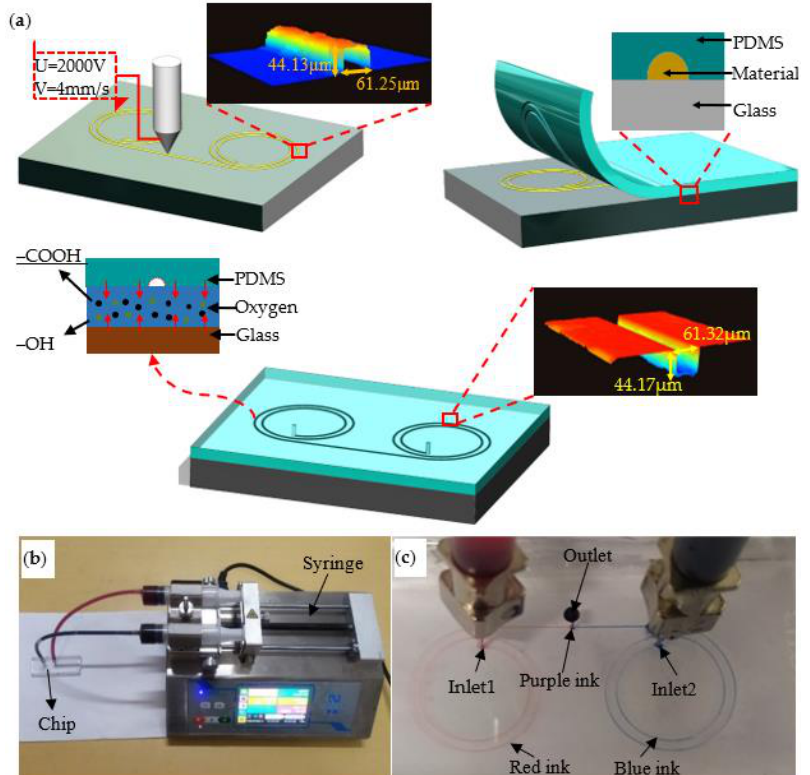
Figure 12. Fabrication of microfluidics chip: ( a ) schematic of microfluidic chip fabrication, PDMS = Polydimethylsiloxane; ( b ) microfluidics chip injection system ,including LEAD FLUID TYD01-02 dual-channel syringe pump (Nanjing, China) and the prepared microfluidics chip; ( c ) mixing and rendering of microfluidics chip.